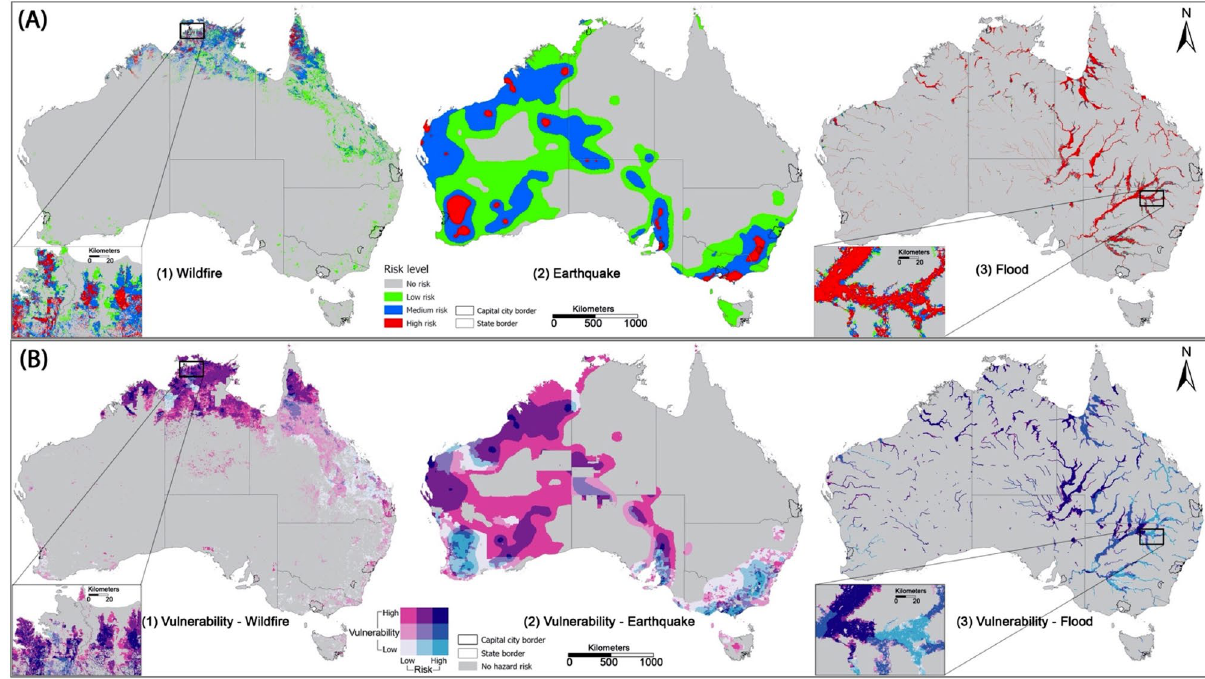
Figure 6. Spatial patterns of (A) three popular natural hazards in Australia and (B) the vulnerability index in hazard-affected areas. In (A), the classification of risk levels is detailed in Method. The risk of natural hazards and level of vulnerability are mapped out using a two-dimensional legend. The vertical colour ramp represents the level of vulnerability while the horizonal colour ramp represents the level of hazard risks. Our interest focuses on the most vulnerable areas with the highest level of risks (dark blue in the northeast corner of the legend). For wildfire, the highly risky and vulnerable areas appear in the north of West Australia, Northern Territory and Queensland (Supplementary Note 4 and Table S10). For earthquakes, the highly risky and vulnerable areas spread out sporadically in Exmouth and Roebuck in the northwest coast of West Australia and East Pilbara in the Midwest of West Australia, outback areas in South Australia, Wellington, Yarram, Foster, and areas along Western Port Bay in Victoria. For flood, the highly risky and vulnerable areas are more prevalent along the rivers, streams and hydrological network in the southwestern inland of Queensland and northeast corner of South Australia (Supplementary Table S10). For wildfire, the highly risky and vulnerable areas mainly appear in the north of West Australia (e.g., Derby), the north of Northern Territory (e.g., West Arnhem, Kakadu National Park, Daly River), and the north peninsula of Queensland (e.g., Cape York). The identified names of the most vulnerable areas in hazard-affected areas are presented in Supplementary Table Table S10. We also enlarge the maps of capital cities to see more detailed locations of the vulnerable areas highly risky in earthquake (Fig. 7 with the place names presented in Supplementary Table S10). Statistically, the mean values of the vulnerability index in earthquake-affected areas of rural Queensland (8.177) and rural Northern Territory (8.638) are substantially higher than that in other states (e.g., 0.898 in urban areas of New South Wales and − 2.446 in ACT) (Fig. 8 and Supplementary Table S11). Finally, we compare the inequality index of vulnerability in hazard-affected areas across urban and rural